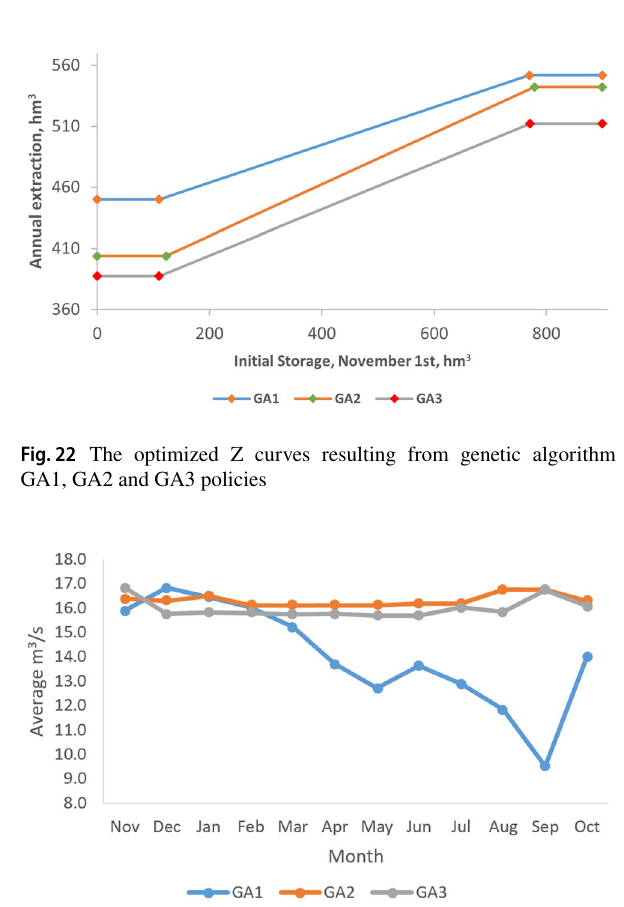
Fig. 23 The average monthly rate of water flow arriving to the Los Berros plant based on genetic algorithm GA1, GA2 and GA3 policies